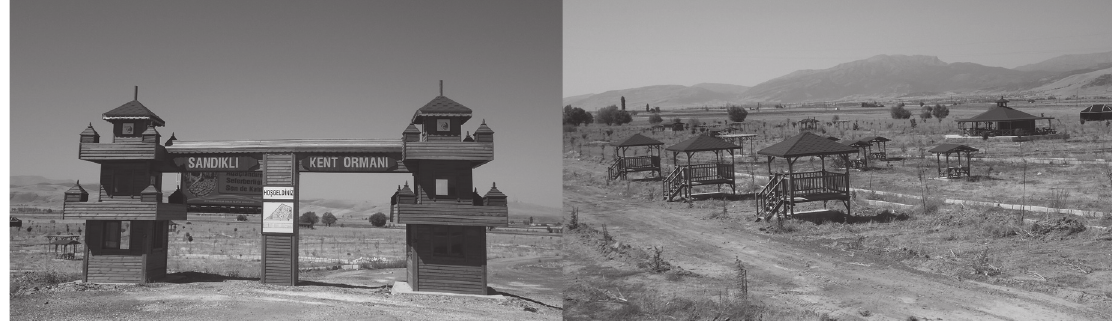
An urban forest in plantation area (Sandıklı/Afyon Urban